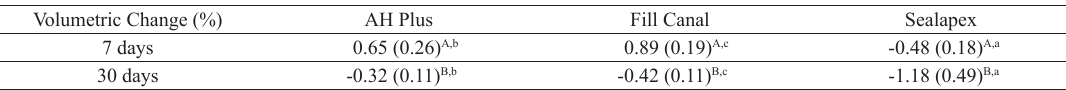
Table 2. Volumetric change values (%) after 7 and 30 days (mean and standard deviation) observed in root canal sealers Volumetric Change (%)